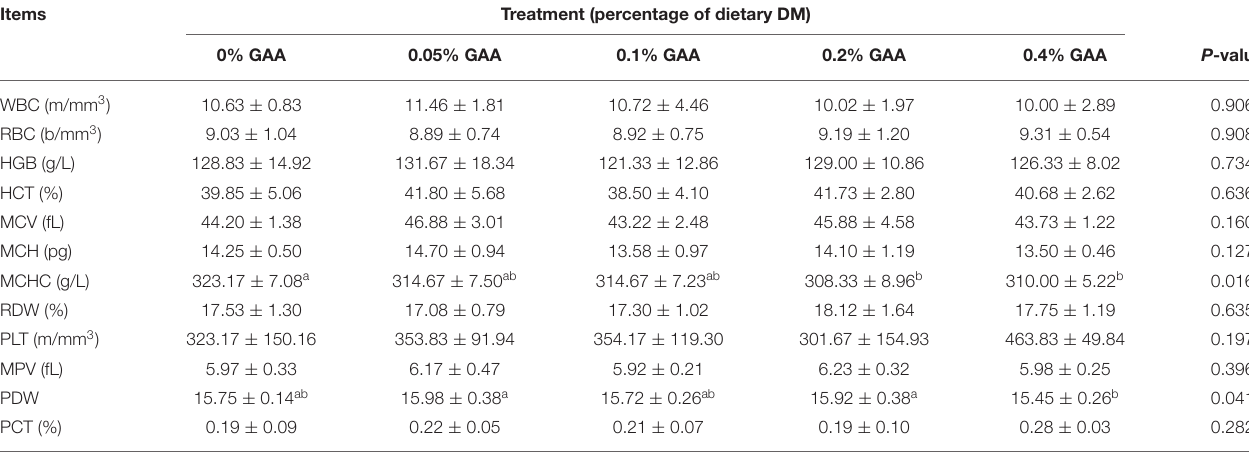
TABLE 3 | Effects of dietary GAA supplementation on blood analysis of Jinjiang